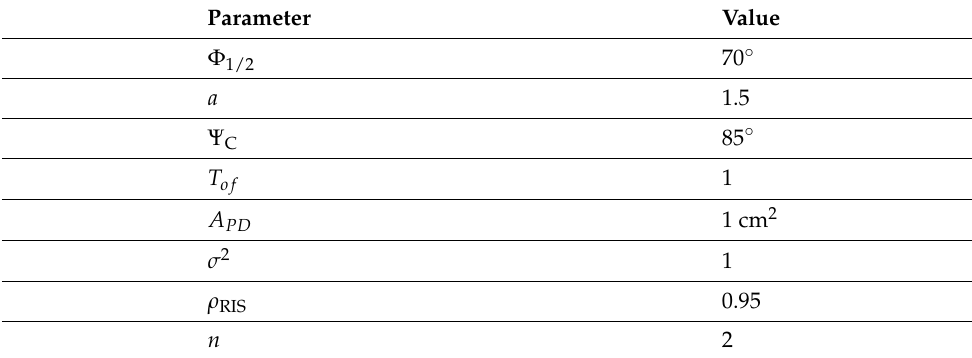
Table 1. Simulation